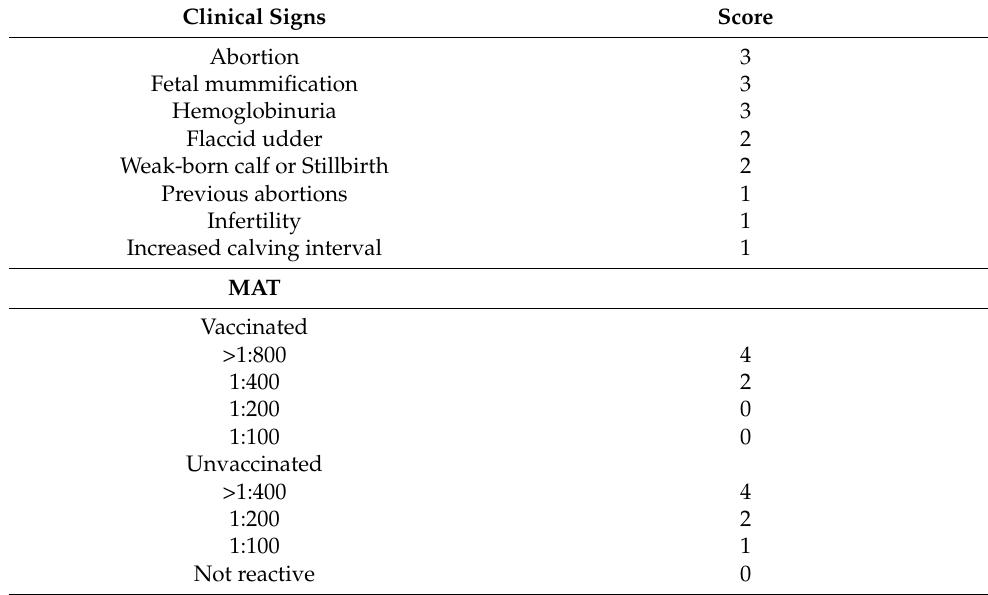
Table 1. Scoring system to determine the final risk level of a cow suffering from leptospirosis according to the clinical signs and the antibody titers against Leptospira spp. by the microscopic agglutination test (MAT). High risk of suffering from leptospirosis (score of 10–15), medium risk (score of 6–9), and low risk (<5